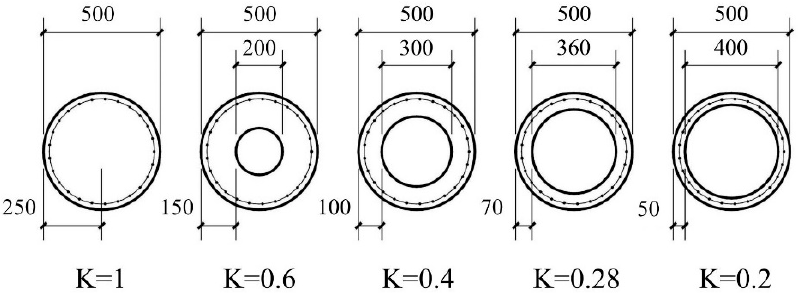
Figure 2. Cross-section of pile model (from left to right: No.1, No. 2, No. 3, No. 4, No. 5).